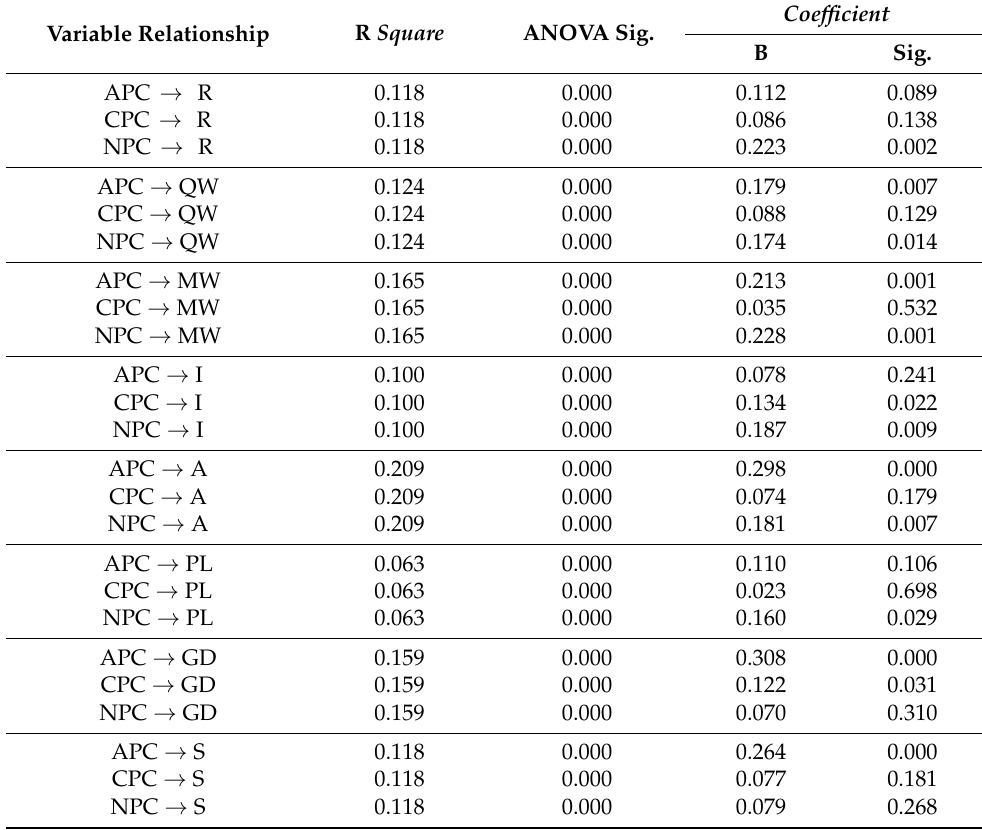
Table 3. Multiple linear regression test of professional commitment and subjective career success. Variable Relationship R Square